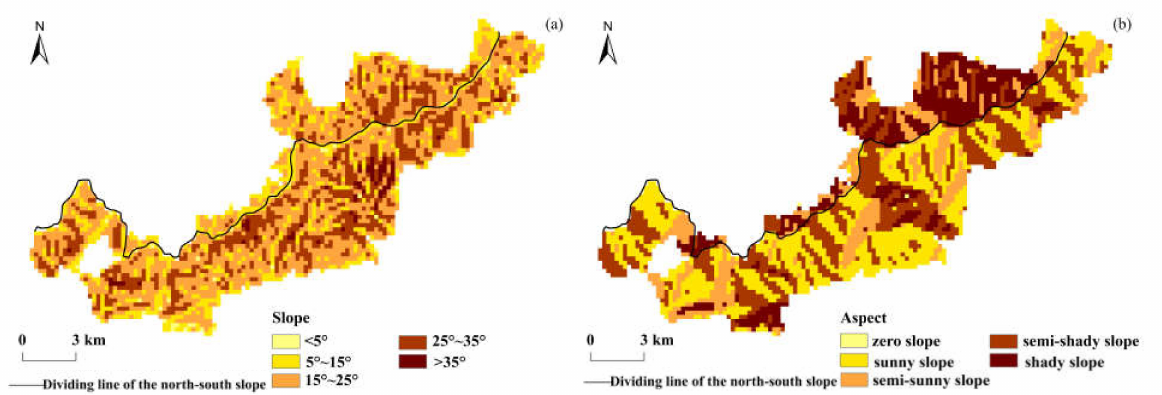
Figure 2. Spatial distribution of the slope and aspect classification in the study area. ( a ) Slope; ( b )